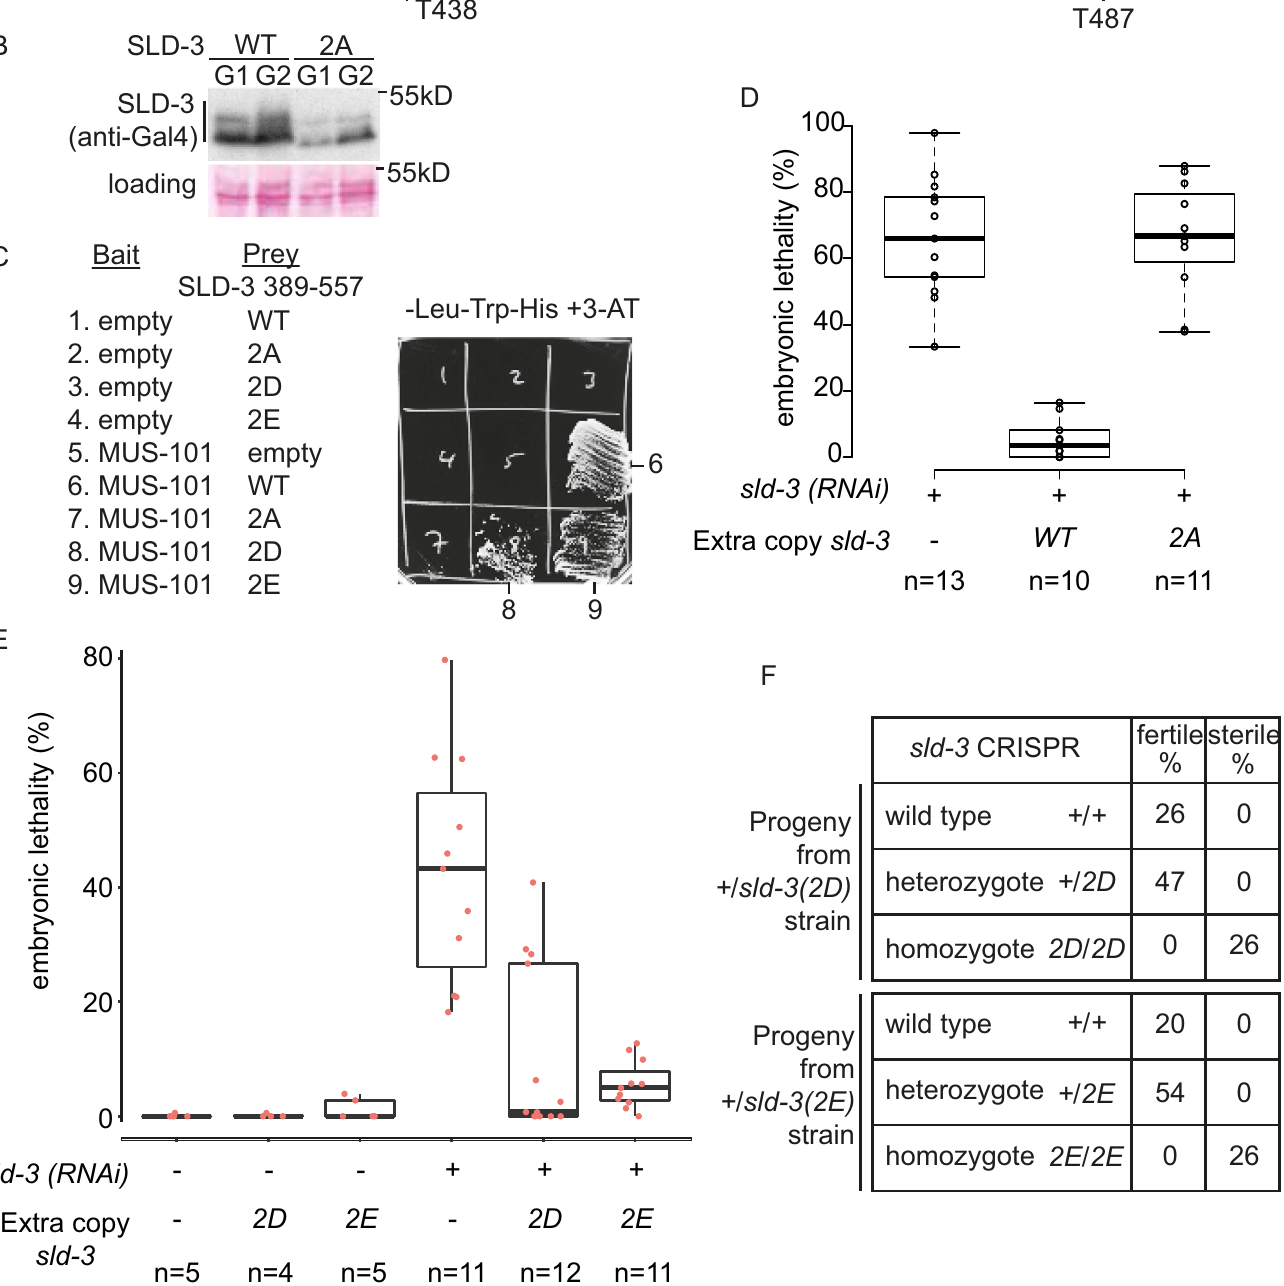
Fig 2. Two CDK sites in SLD-3 are essential for the interaction with MUS-101 A. Alignment of the CDK sites in Sld3/Treslin required for the interactions with Dpb11/TopBP1. The amino acid numbers of the two orthologous CDK sites in C . elegans SLD-3 are indicated below. B. Western blot of Gal4-SLD-3 (389–557) wild type (WT) or the 2A mutant expressed in yeast arrested either in G1 phase (low CDK activity) with alpha factor, or arrested in G2 phase (high CDK activity) with